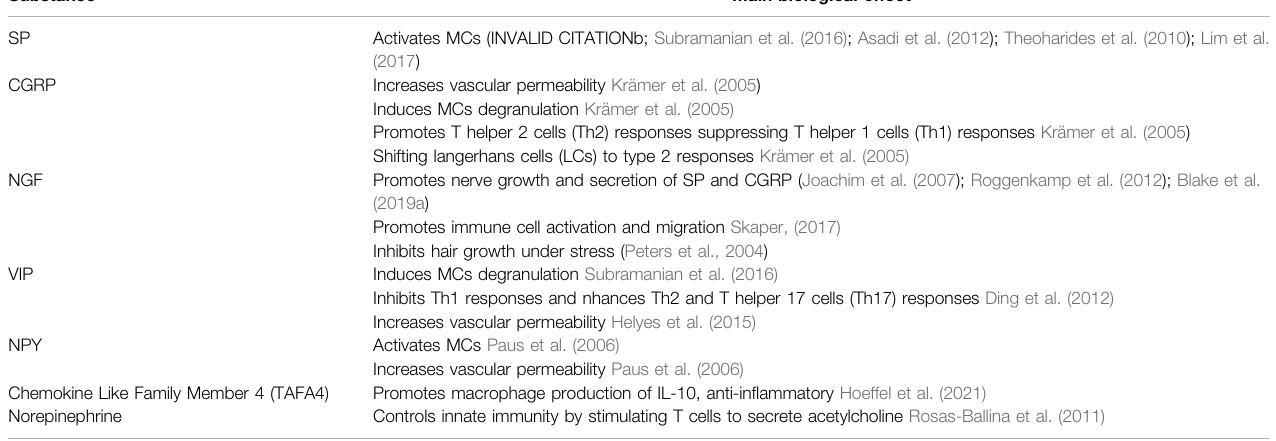
TABLE 1 | The role of neuropeptide in cutaneous neuroimmune crosstalk. Substance